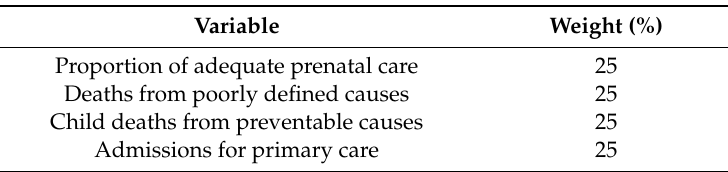
Table 3. Health Area - Weights of